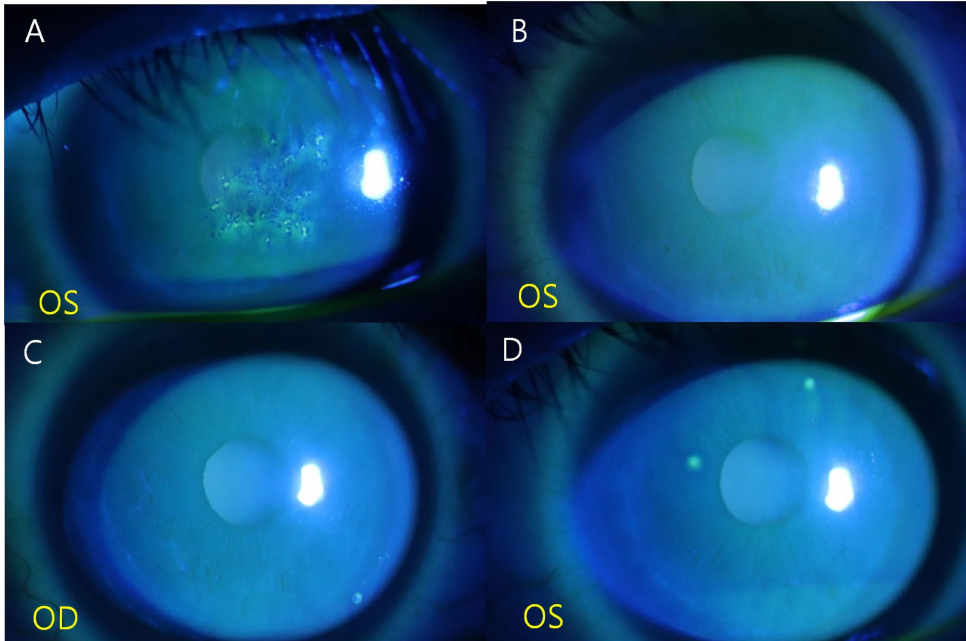
Figure 2. At 16 weeks after the initial presentation, the central corneal lesion with multiple elevated lesions was observed in the left eye ( A ) and the corneal lesion improved after 1 week ( B ). No recurrence was observed 3 months after the last event in both eyes ( C , D